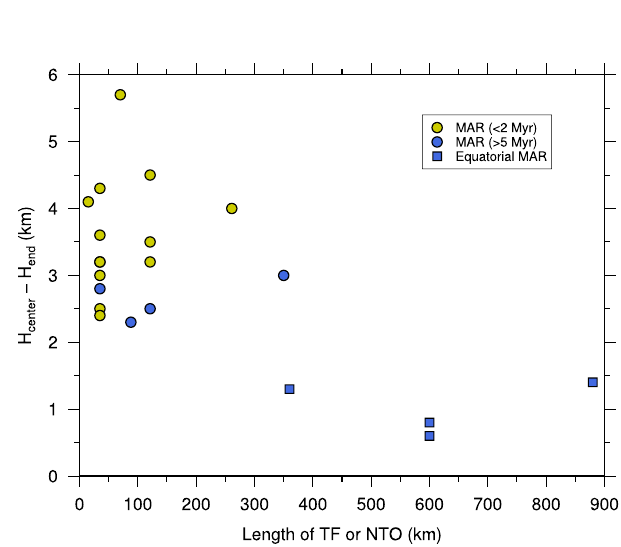
Fig. 8 | Crustal thinning versus length of tectonic discontinuities. Crustal thinningtowardsoceanictransformfault(TF)ornon-transformoffset(NTO)inthe Atlantic Ocean as a function of the length of TF or NTO. Only crustal thickness constrained by active-source seismic data is considered. The blue squares show results from this study for the equatorial Atlantic. For a TF composed of several intra-transform faults, the total length of the TF is used. Data sources are given in Supplementary Table